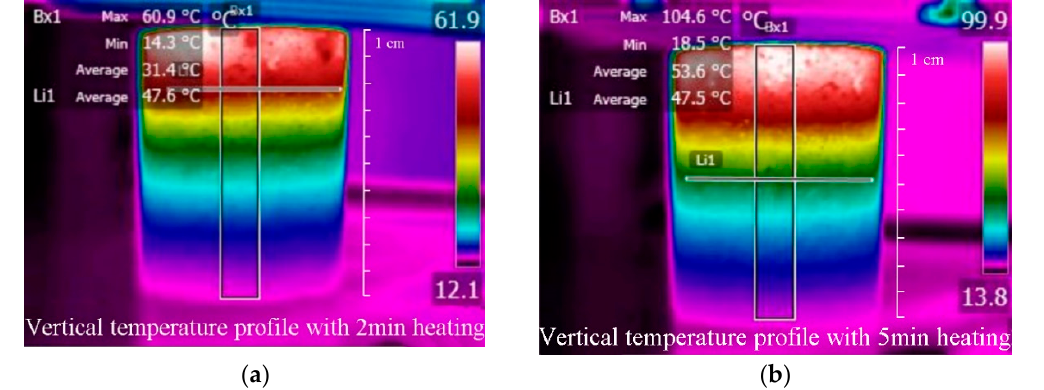
Figure 4. Infrared images of the core after induction heating at a heating distance of 30 mm. ( a ) Vertical temperature profile of the sample with 2 min heating. ( b ) Vertical temperature profile of the sample with 5 min heating.